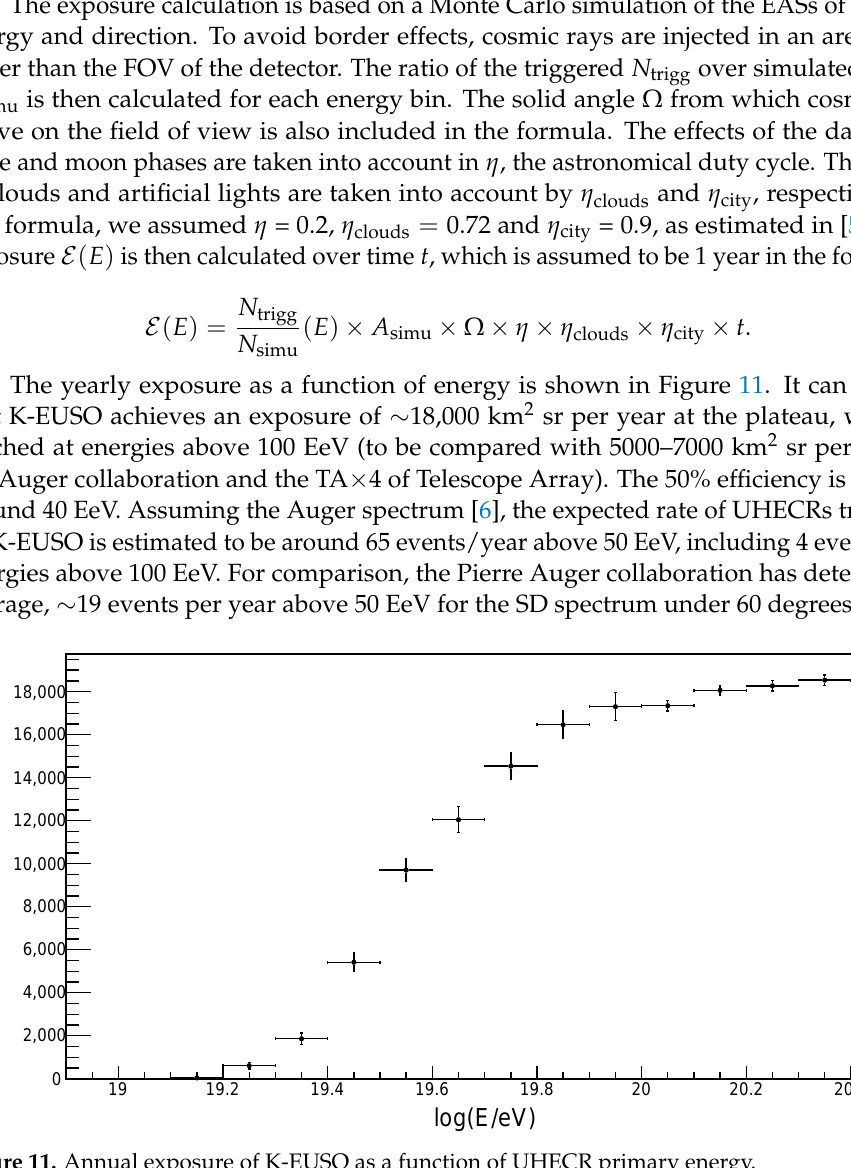
Figure 11. Annual exposure of K-EUSO as a function of UHECR primary